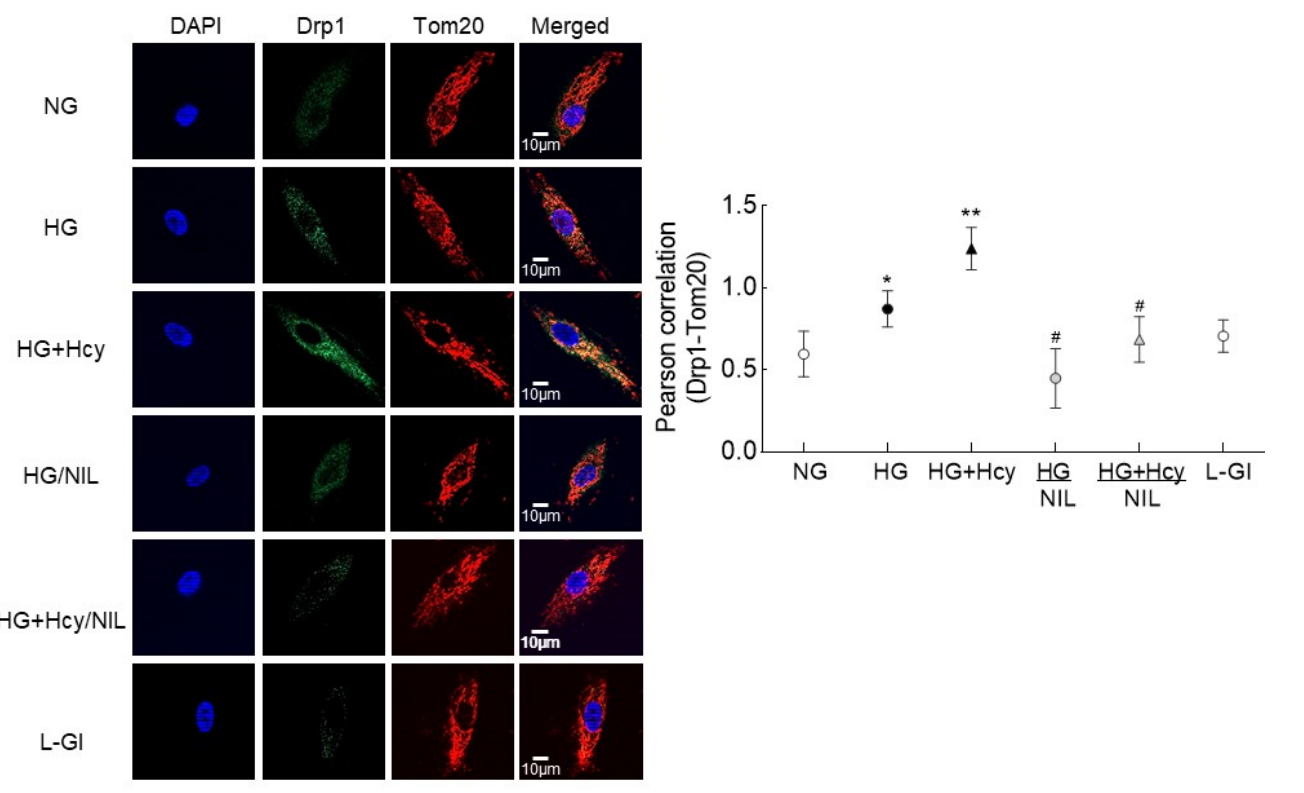
Figure 4. Mitochondrial translocation of Drp1. Mitochondrial localization was determined by im- munofluorescence technique using Alexa Fluor–488 (green) conjugated secondary antibody for Drp1 and Texas red conjugated for the mitochondrial marker Tom20. DAPI-containing (blue) Vectashield mounting medium was used for mounting the cells, and the cells were imaged using a 63 × oil objective lens on a ZEISS microscope. Pearson’s correlation coefficient between Drp1 and Tom20 was calculated using the colocalization ZEISS software module. The values in the graphs are pre- sented as mean ± SD obtained from 3–4 different cell preparations. NG, cells in normal glucose; HG and HG + Hcy, cells in high glucose and high glucose + homocysteine respectively; HG/NIL and HG + Hcy/NIL, cells in high glucose containing NIL in the presence or absence of homocysteine, respectively; L-Gl, 20 mM L-glucose; * p < 0.05 compared to NG; ** p < 0.05 compared to HG; # p > 0.05 compared to